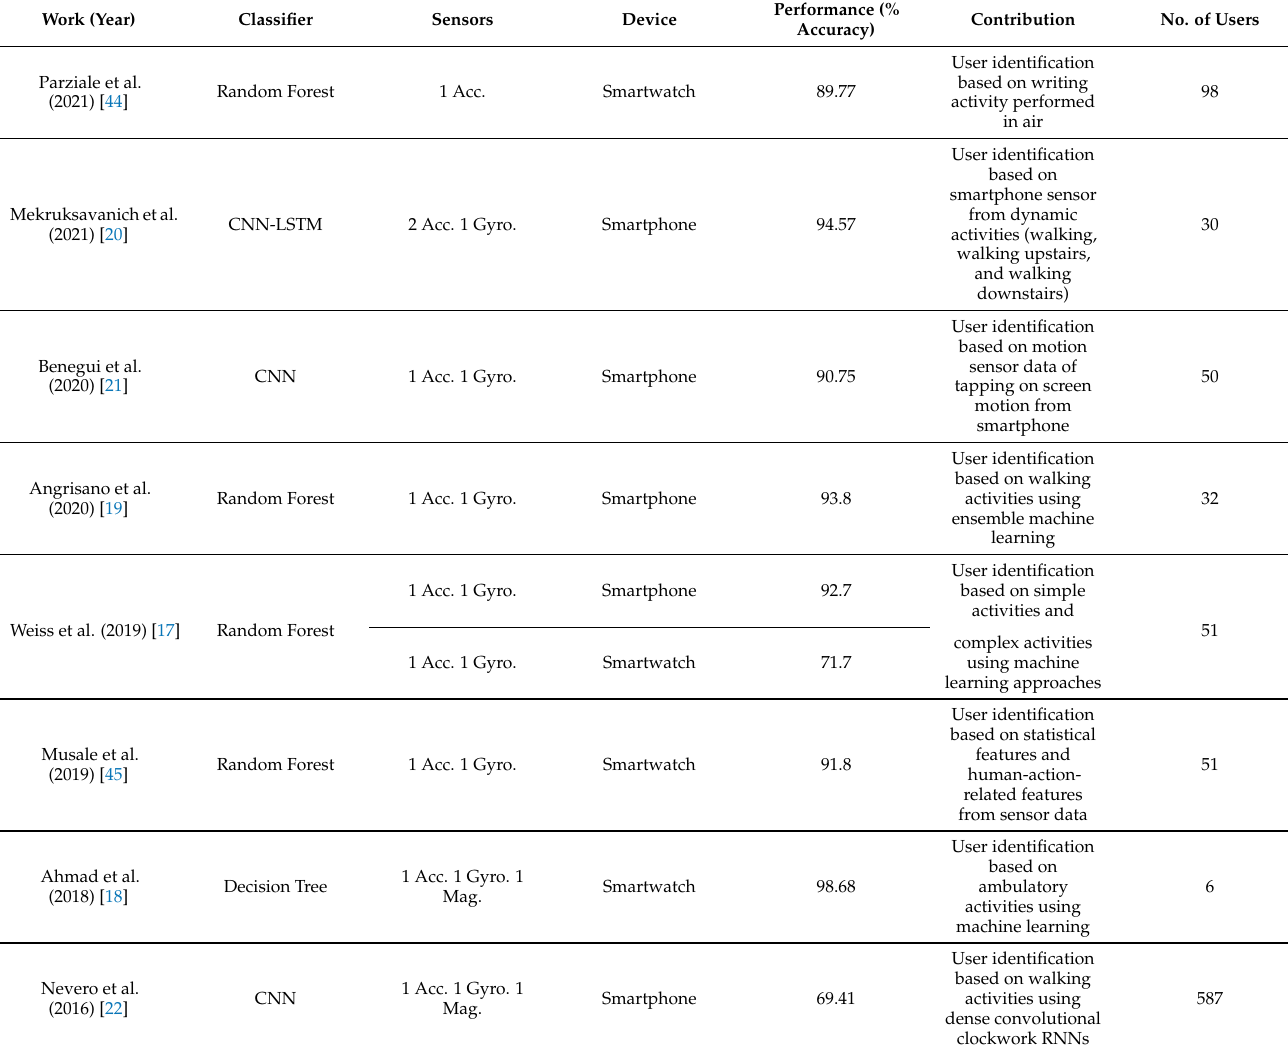
Table 1. A summary of existing literature on user identification based on the sensor